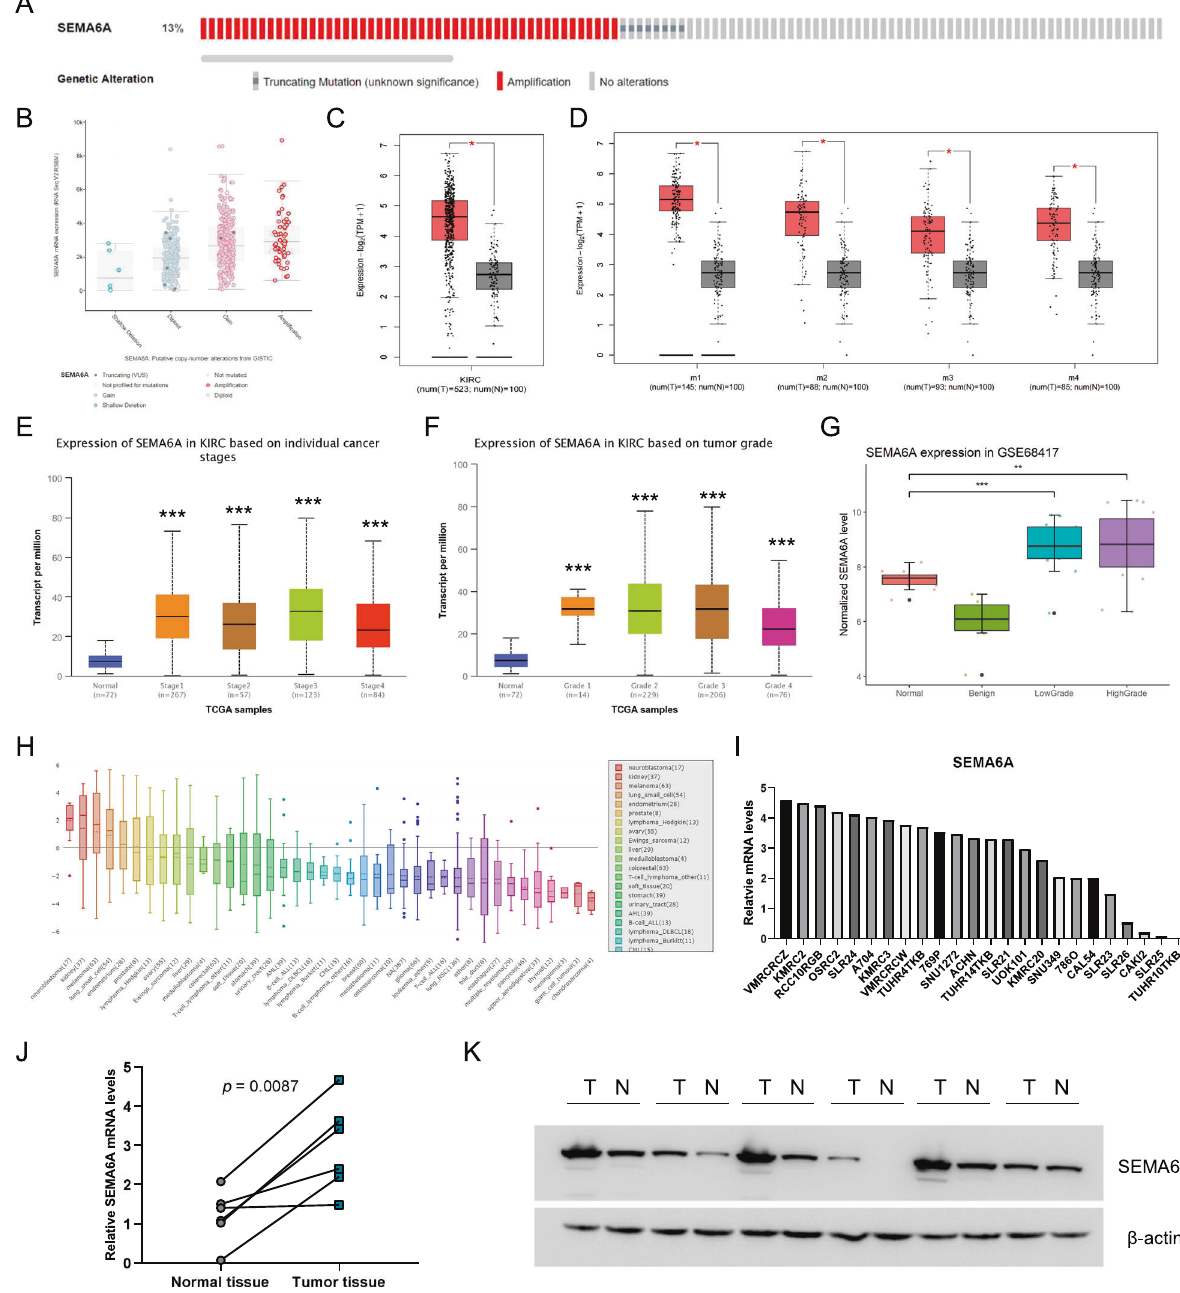
Fig. 3 SEMA6A is overexpressed in ccRCC patients. A Mutation of SEMA6A in ccRCC was obtained through the online cBioPortal database (http://www.cbioportal.org/). B Copy number and mutation types of the expression of SEMA6A in ccRCC. (TCGA, Firehose Legacy; 538 total samples; Genome map selection: Mutations, Putative copy-number alterations from GISTIC, mRNA expression z -scores relative to diploid samples (RNA-Seq V2 RSEM). C mRNA expression of SEMA6A in the TCGA database obtained through the GEPIA website (http://gepia.cancer- pku.cn). Red represents ccRCC tissue and black represents normal tissue. * p < 0.05. D Correlation between SEMA6A expression and ccRCC subtypes from TCGA database obtained through the GEPIA website (http://gepia.cancer-pku.cn). Red represents ccRCC tissue and black represents normal tissue. * p < 0.05. E Correlation between SEMA6A expression and the tumor stage of ccRCC patients was obtained through the UALCAN database (http://ualcan.path.uab.edu). F Correlation between SEMA6A expression and the tumor grade of ccRCC patients was obtained through the UALCAN database (http://ualcan.path.uab.edu). G Box plot of the difference in the expression level of SEMA6A in the GSE68417. Red represents normal tissues, green represents benign tissues, blue represents low-grade ccRCC tissues, and purple represents high-grade ccRCC tissues. ** p < 0.01, *** p < 0.001. H mRNA expression of SEMA6A in cell lines from different cancer types was obtained through the CCLE website (https://sites.broadinstitute.org/ccle). I Bar graph of SEMA6A mRNA expression in several kidney cancer cell lines. J , K The mRNA and protein levels of SEMA6A in six paired ccRCC tissues and adjacent normal kidney tissues.